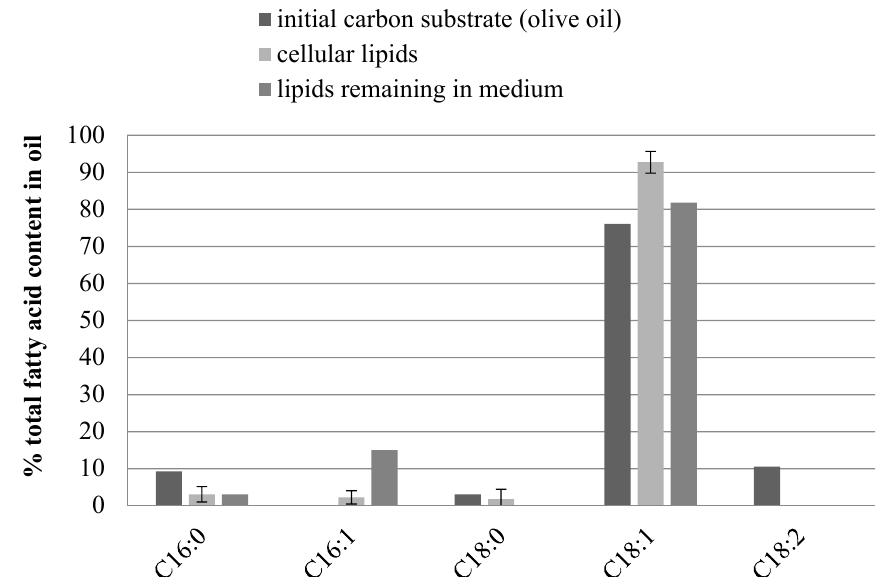
Figure 3. Comparison of fatty acid content in lipids synthesized in cells during Y. lipolytica batch cultures in MO5 medium with fatty acid content in initial carbon substrate and lipids remaining in culture medium–residual oil (abbreviations: C16:0-palmitic acid, C16:1-palmitoleic acid, C18:0-stearic acid, C18:1-oleic acid, C18:2-linoleic